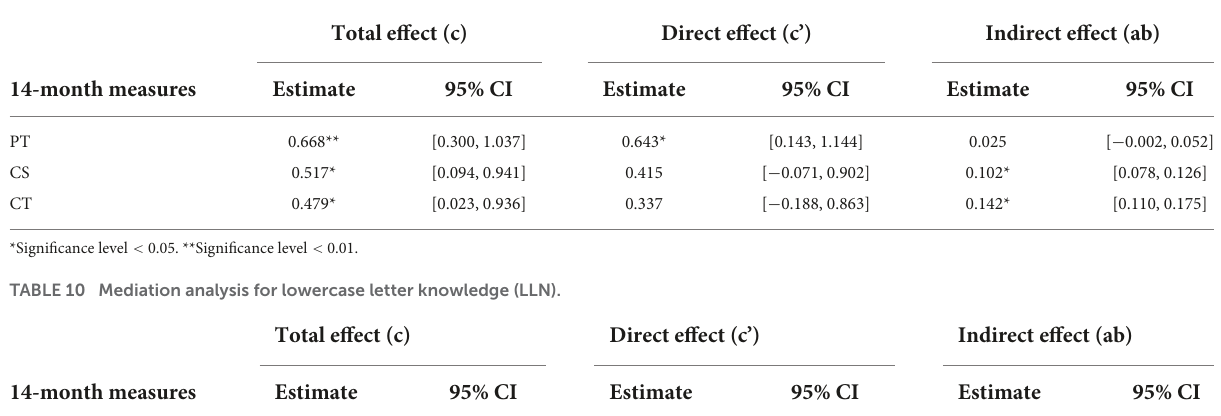
TABLE 9 Mediation analysis for uppercase letter sound knowledge (ULS).